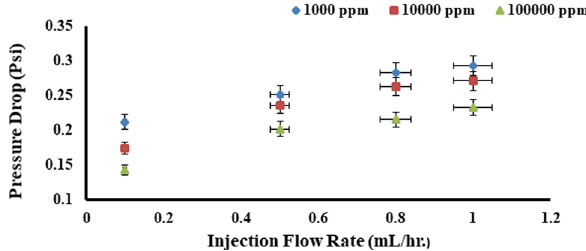
Fig. 4 Pressure drops versus injection flow rates for a simple fracture micromodel at different saline concentrations including 1000, 10,000, and 100,000 ppm at T = 25 °C and P = 0.846 bar